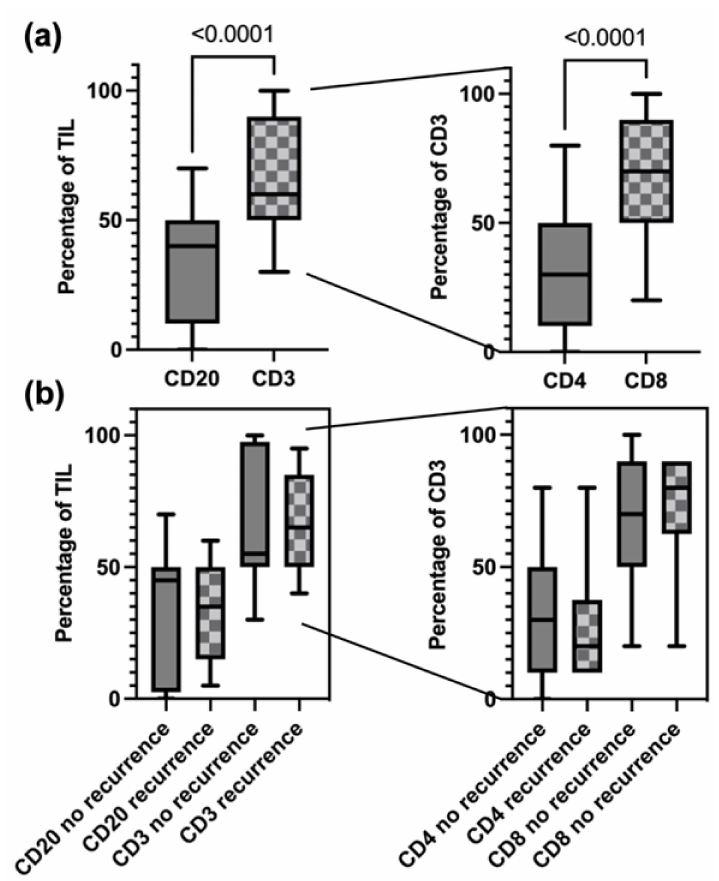
Figure 3. Distribution of TIL subtypes in the whole cohort ( a ) and with respect to recurrence ( b